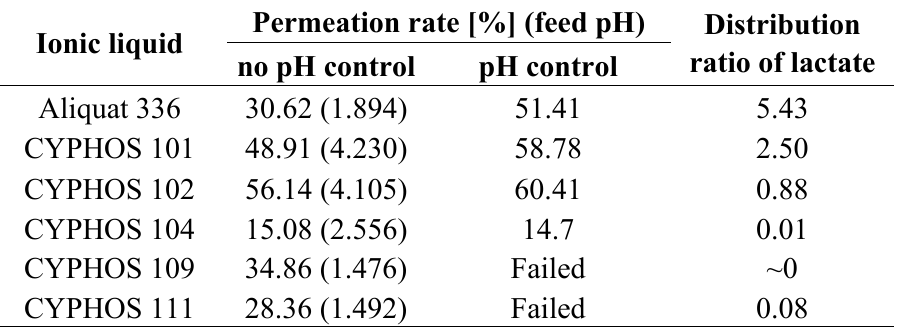
Table 3. Permeation rates of lactate through SILMs with and without pH control, pH value of feed phase after 24 h and distribution ratio of lactic acid for the various ionic